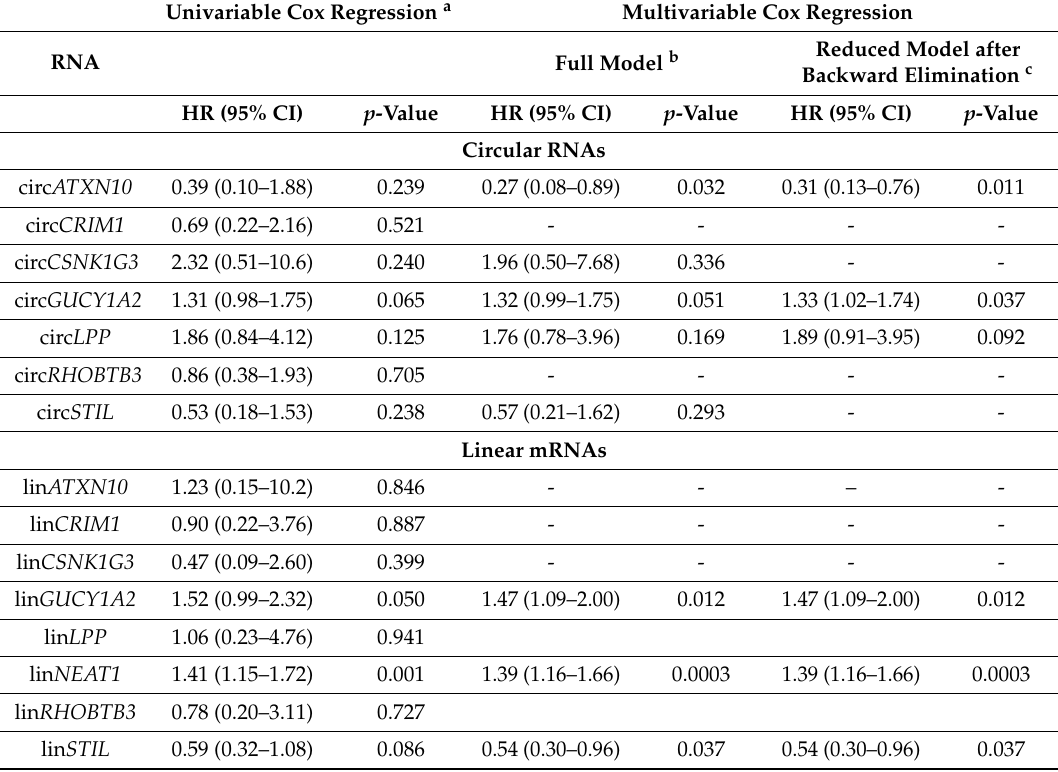
Table 6. Construction of separate tools for prediction of biochemical recurrence using circRNAs and their linear